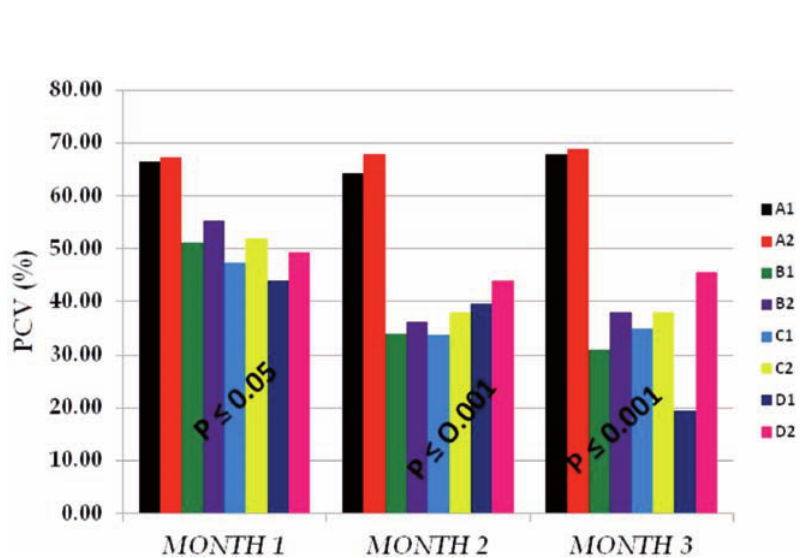
Figure 3. The packed cell volume (PCV %) mean values of the different subgroups for 3 months study